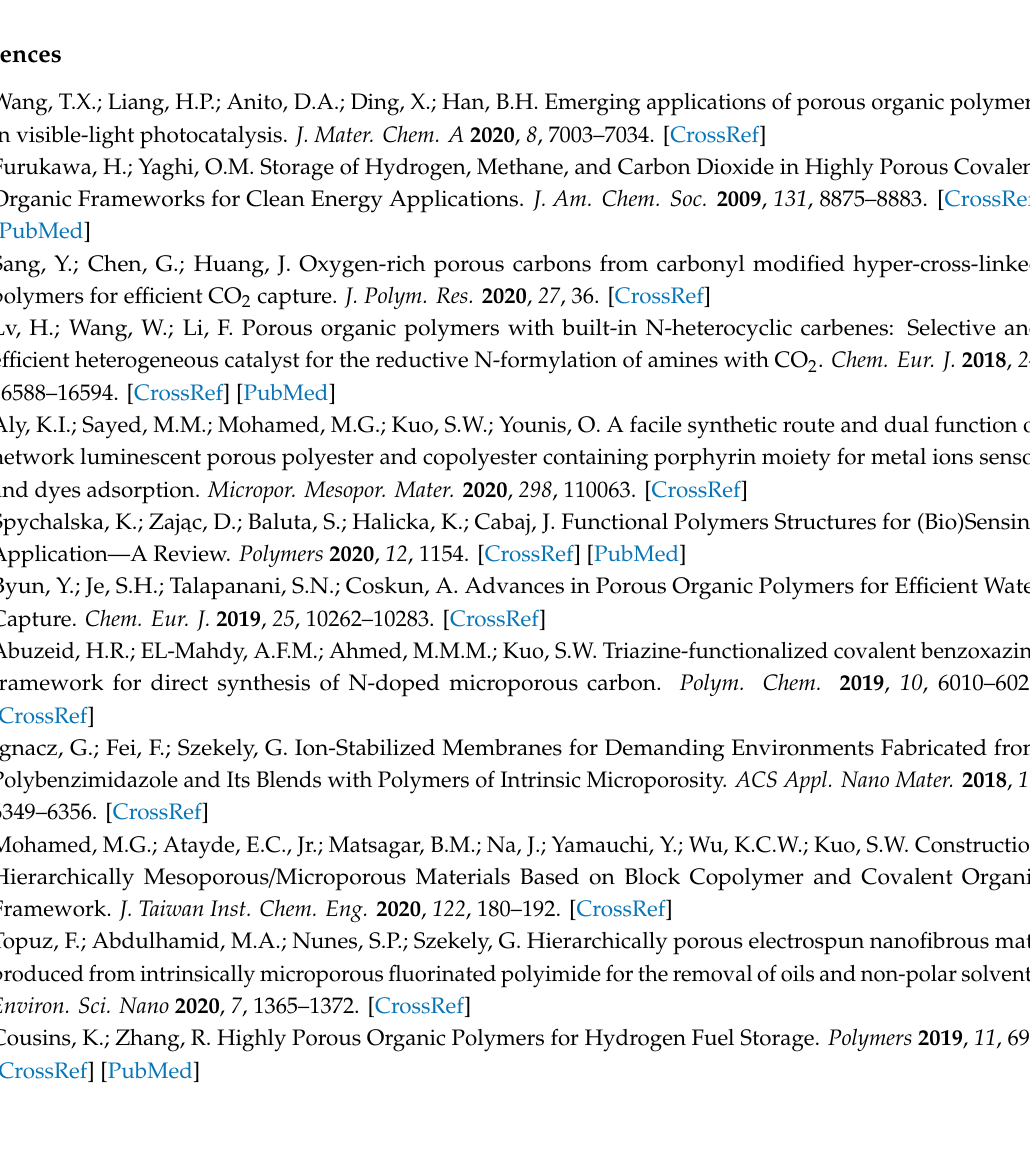
Figure S1 : 1 H NMR spectrum of TPE. Figure S2 : 13 C NMR spectrum of TPE. Figure S3 : 1 H NMR spectrum of DPT. Figure S4 : 13 C NMR spectrum of DPT. Figure S5 : FT-MS pattern of DPT. Figure S6 : XRD pattern of (A) TPE-HPP and (B) DPT-HPP. Figure S7 : Reusability of (A) TPE-HPP and (B) DPT-HPP for the removal of RhB MB within 60 min. Figure S8 : Ragone plots of the energy density and power density of the (A) TPE-HPP and (B) DPT-HPP electrodes in 1 M KOH. Table S1 : Comparison between the specific surface area / specific capacitance of TPE-HPP and DPT-HPP with those of previously reported POPs and related materials for supercapacitor